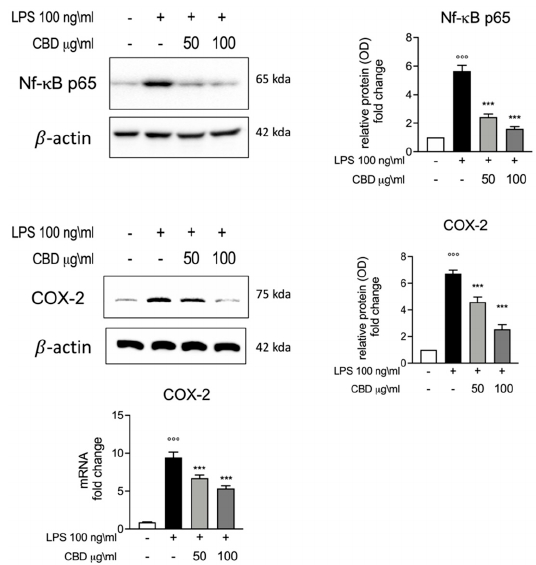
Figure 3. Upper panels, Western blot analysis for Nf- κ B expression and relative comparative fold change graph. Lower panel, Western blot and rt-PCR analysis for COX-2 protein and mRNA expression among the different experimental groups. Data are presented as means ± SEM for each group. °°° p < 0.01 vs. control; *** p < 0.001 vs. LPS.